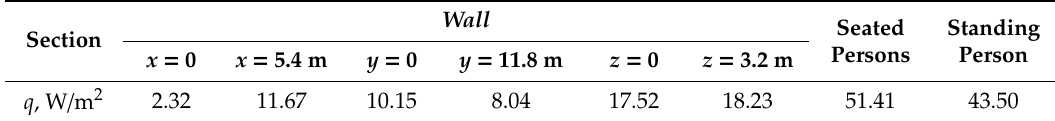
Table 3. Temperature boundary conditions for room interior